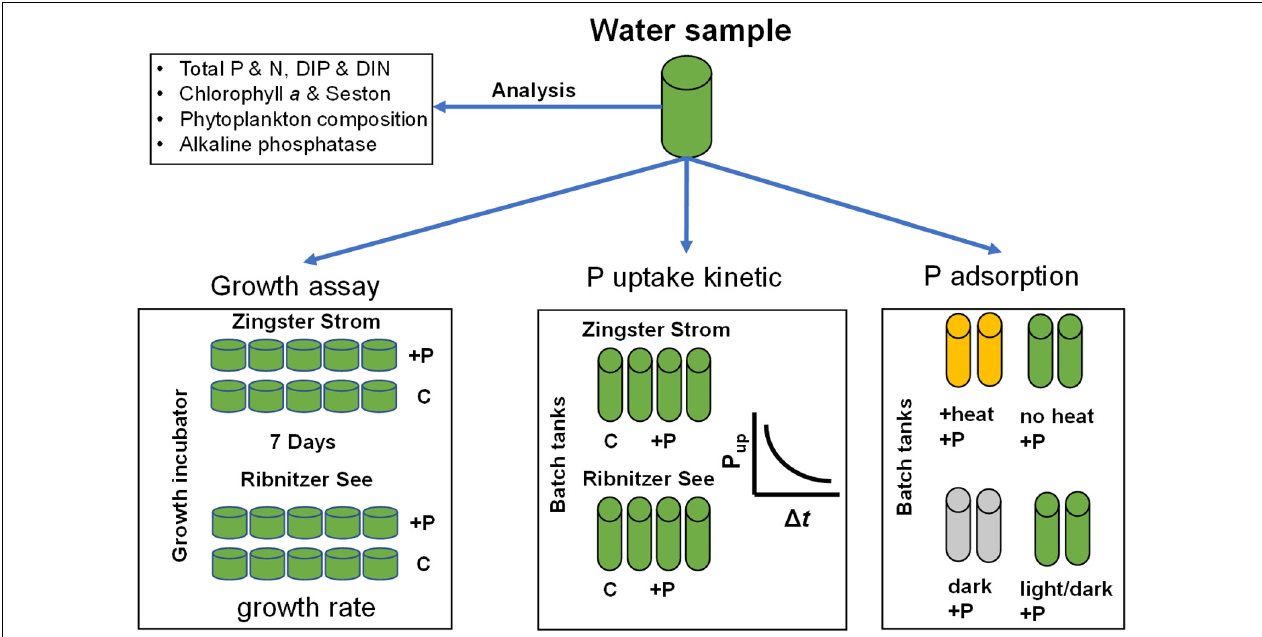
FIGURE 2 | Scheme of the experimental and analytical workflow. P, phosphorus; N, nitrogen; DIP, dissolved inorganic phosphorus; DIN, dissolved inorganic nitrogen (sum of nitrate, nitrite, ammonium); C, control; +P, phosphate addition to final concentration of 10 µ mol l − 1 . Heat experiment – pre-incubation at 70 ◦ C for 1 h, dark–dark incubation for at least 12 h.